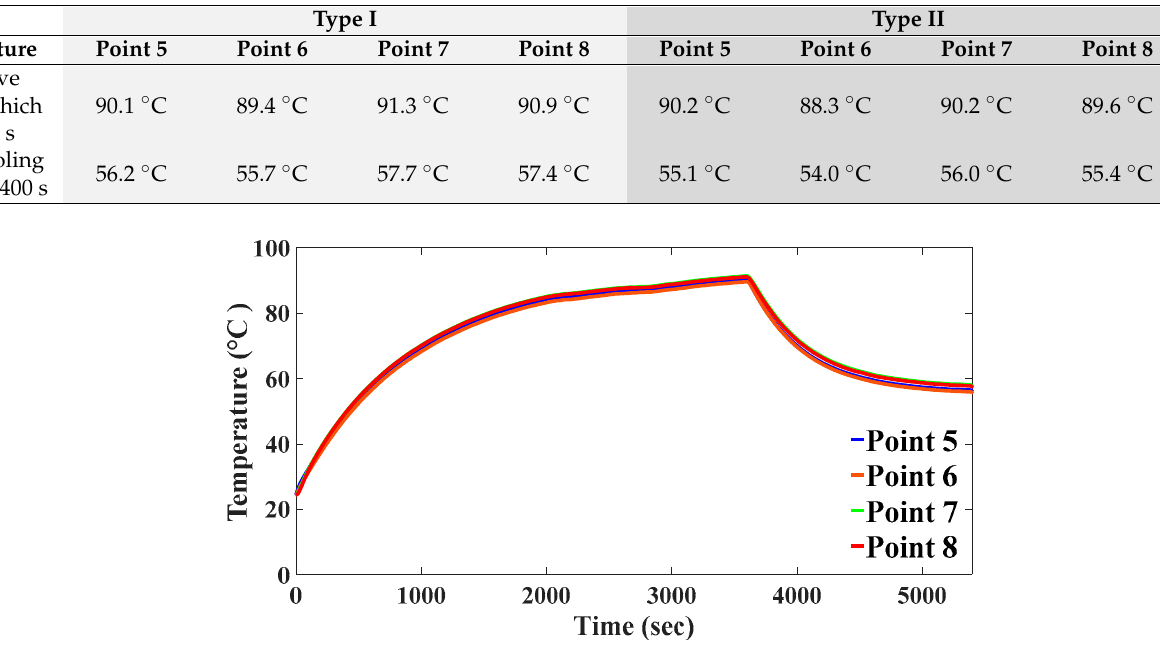
Figure 22. Temperature responses in Type I heat-source point.